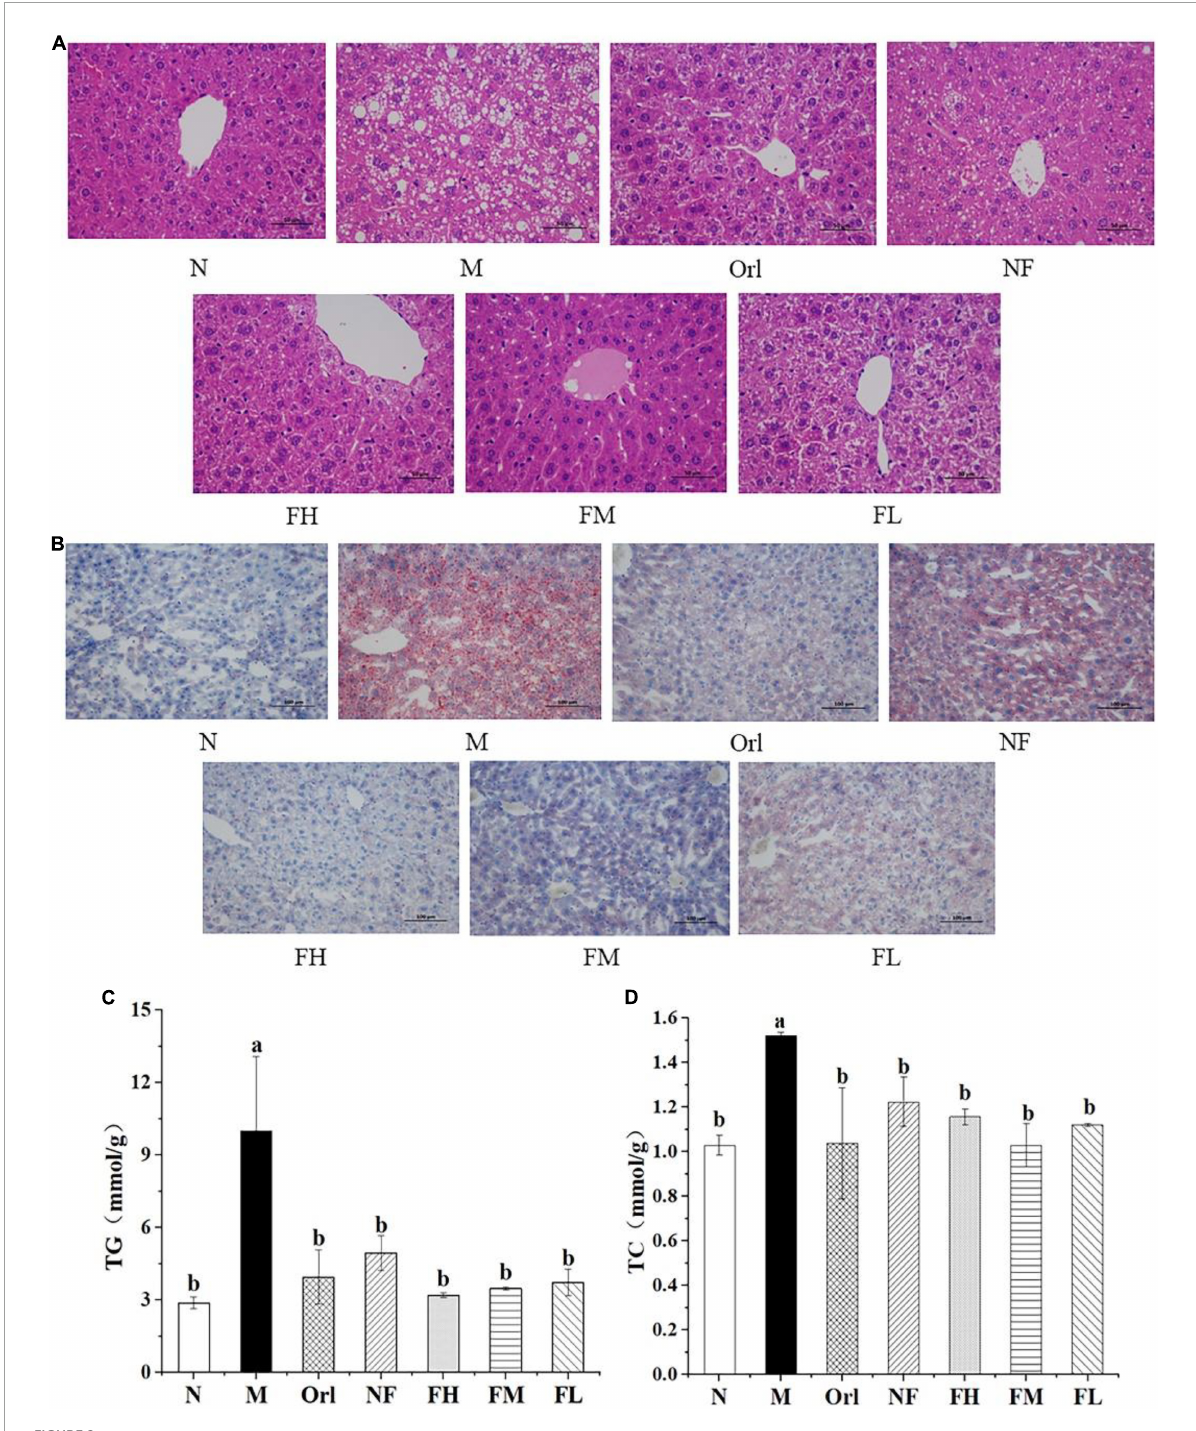
FIGURE2 Effects of FAK on the mice liver. (A) H&E staining of liver (scale bar = 50 µ m). (B) Oil-Red-O staining of liver (scale bar = 100 µ m). (C) TG levels in liver. (D) TC levels in liver. All data are expressed as mean ± SD ( n = 5). (a,b) Bands with different letters indicate significant differences ( P < 0.05).